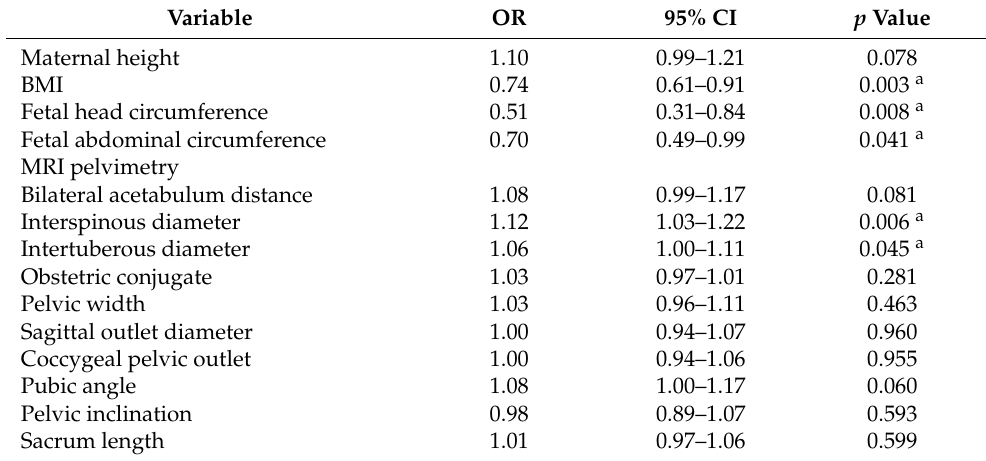
(Table 2), and multivariate logistic regression introduced five factors, including HC, AC, ITD, ISD, and pre-pregnancy BMI (Table 3), which we used to develop a nomogram that predicts the vaginal delivery probability (Figure 3). Table 2. The Variables of Vaginal Birth in the Test Set Using Univariate Logistic Regression Analyses ( n = 75).